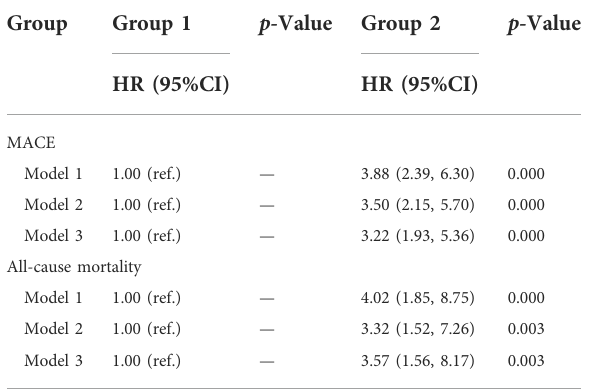
FIGURE 4 Kaplan – Meier curves for all-cause mortality according to quartiles of serum Cys-C. Log-rank test: p = 0.000 (Quartile 1 V S. Quartile 4). Quartile 1: Cys-C ≤ 0.81 mg/L; Quartile 2: 0.81 <